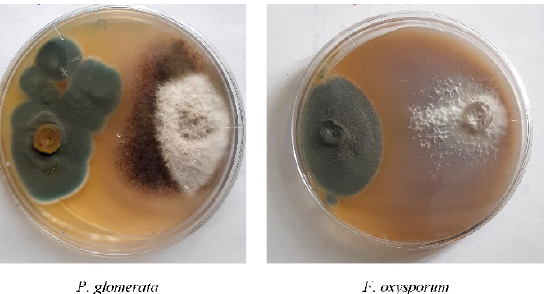
Figure 1. Antagonistic activity of Penicillium chrysogenum VKPM F-1310 towards Phoma glomerata 100085 and Fusarium oxysporum MP-14-6 (7th day of incubation). 100085 and Fusarium oxysporum MP-14-6 (7th day of